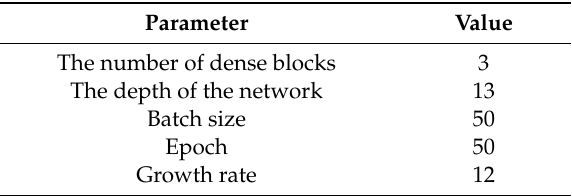
Table 7. The consistent parameters of the original DenseNet.